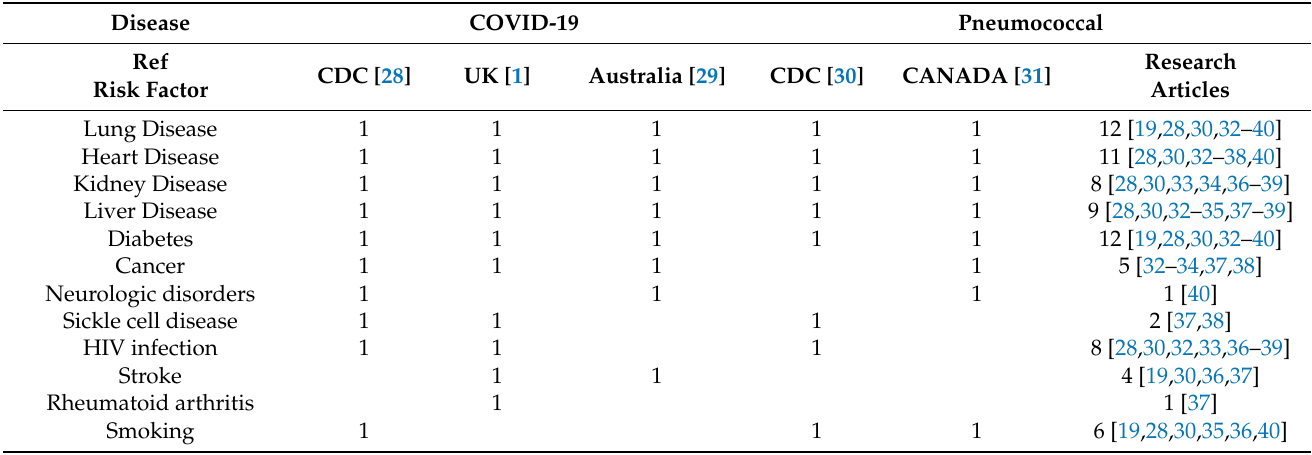
Table 1. Correlation between the COVID-19 and pneumococcal disease risk groups.